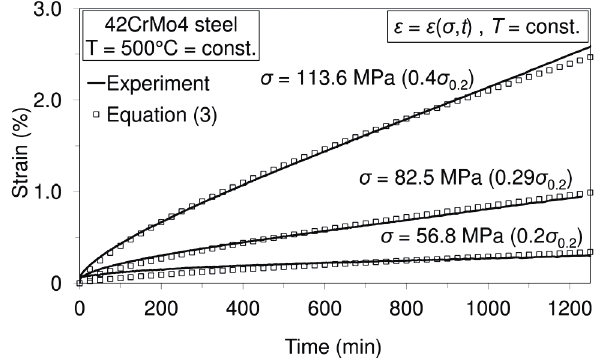
Fig. 8: Creep behavior modeling of 42CrMo4 steel at the temperature of 500 °C (773 K); case: e = e ( s , t ), T = const; modeling using the analytical